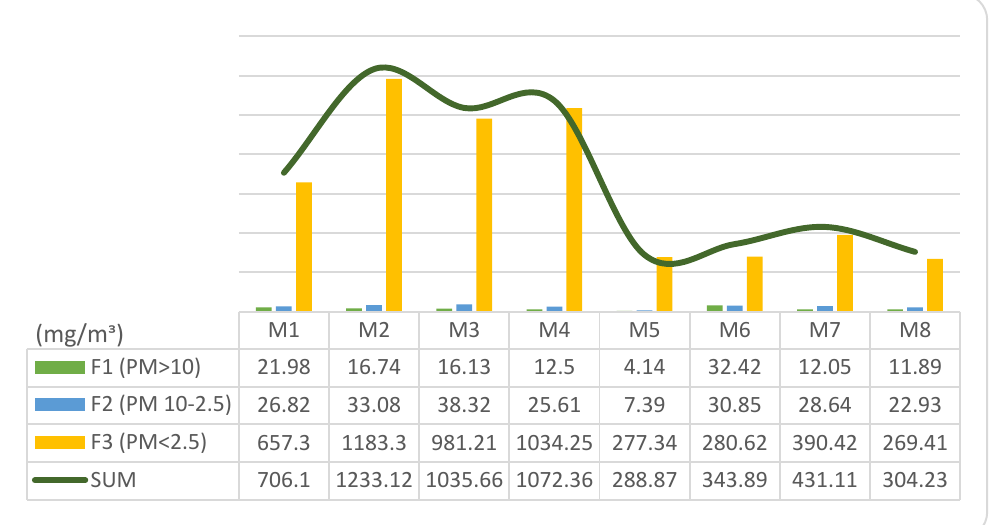
Figure 6. Amount of PM emissions for measurements of variant 1.